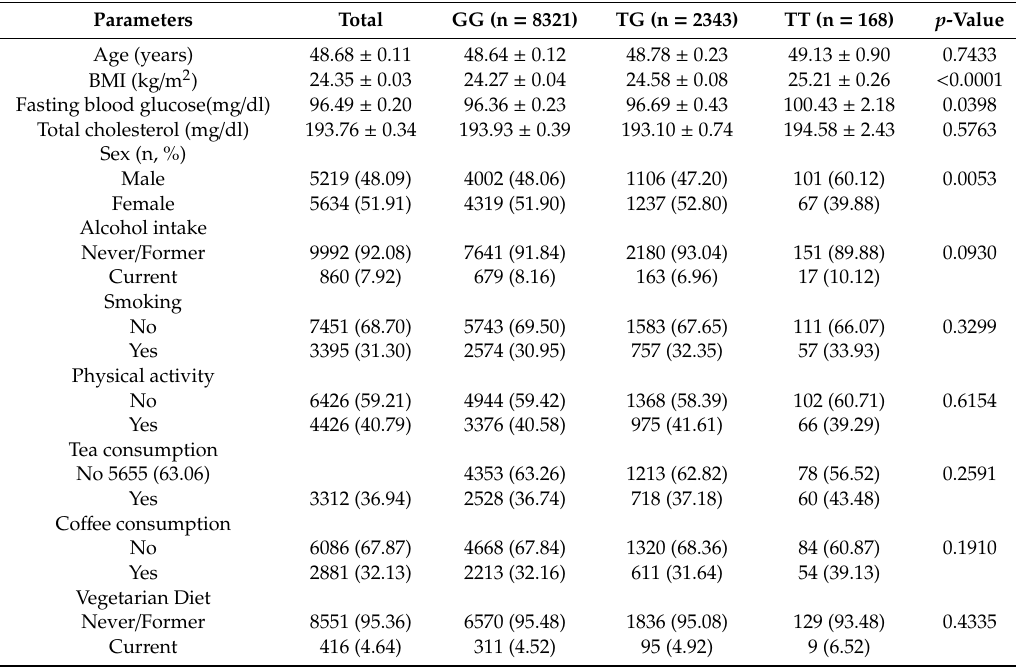
Table 1. Characteristics of study participants according to rs3751812 genotypes.